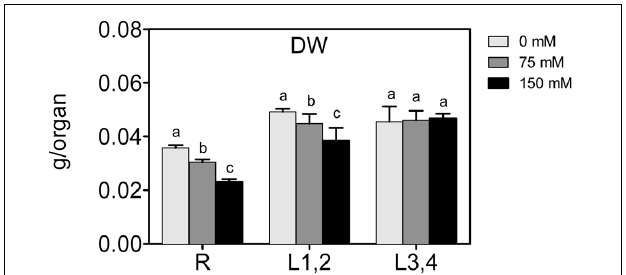
FIGURE 2 | Effect of different salinity levels on Na + , Cl − , and K + ion content of root (R), mature leaf pair (L1,2), and young leaf pair (L3,4) of 3 weeks old maize seedlings. Values are means of at least three replicates and significant differences between means, as determined by Duncan test ( P < 0.05), are indicated by different